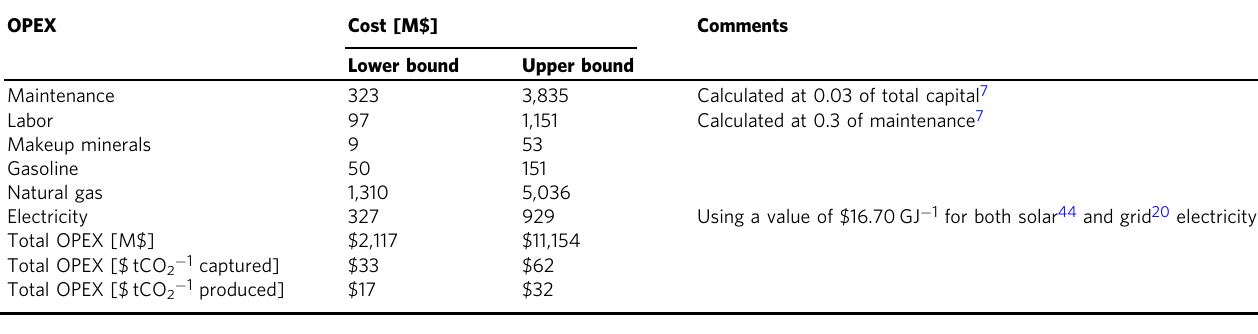
Table 4 Operating expenditures (OPEX) for the MgO looping process.